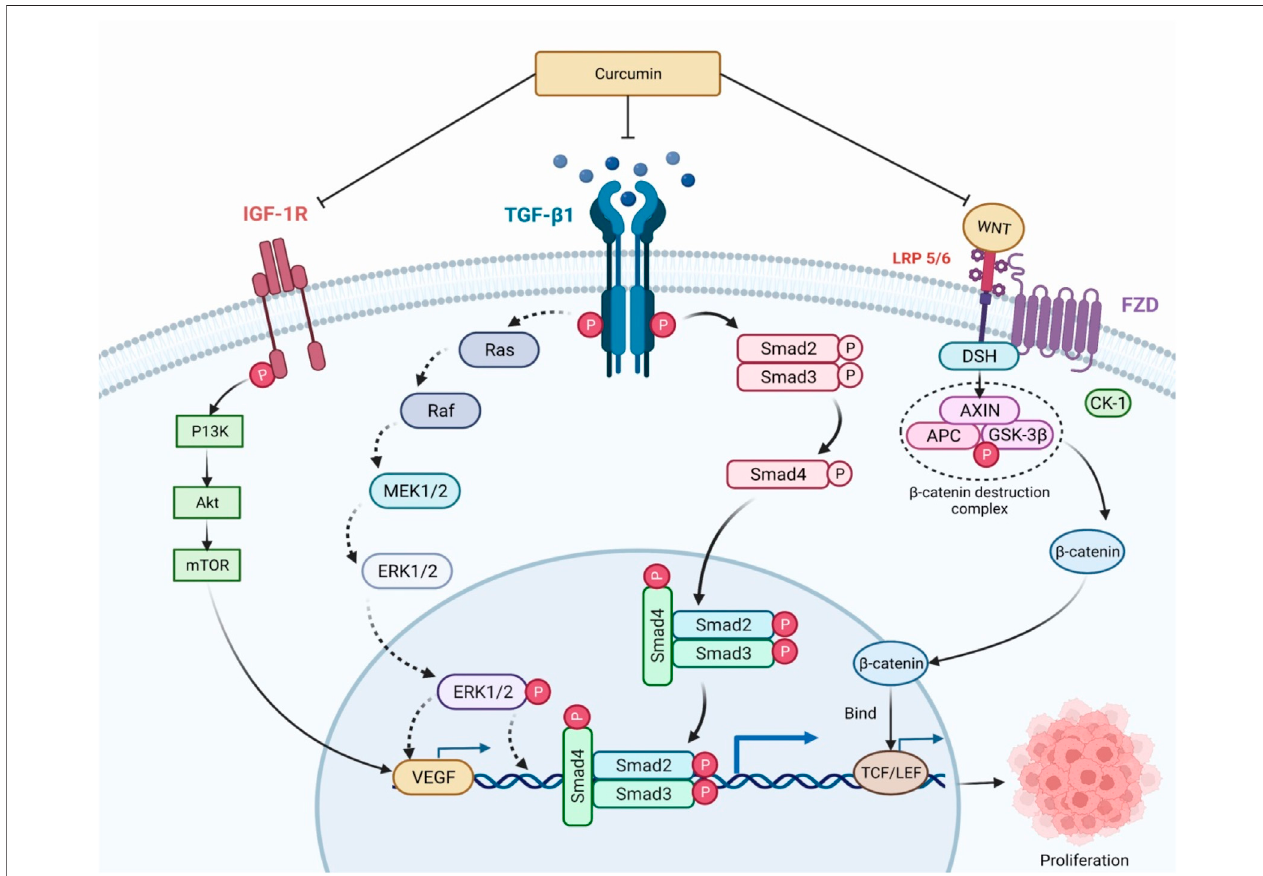
FIGURE 7 | Mechanism of curcumin in regulation of cancer proliferation. TGF- β 1/smad3, IGF, PI3K/Akt, Wnt/ β -catenin, and vascular endothelial growth factor (VEGF)aresomeofthesignalingpathwaysandmoleculartargetsthatcurcuminmodulatestoinhibitcancer.Blockingthesereceptorshasthepotentialtoreducechronic in fl ammation and oxidative damage. DSH and AXIN are recruited once the WNT binds to LRP 5/6, producing the β -catenin destruction complex. β -catenin that has escapedintothenucleuspromotesthetranscriptionofgenesincludingcyclinD1andP13k,whichpromotecellproliferationandgrowth.IGF-1R,Insulin-likegrowth factor 1 receptor; TGF- β 1, Transforming growth factor beta 1; WNT, Wingless/integrated; LRP 5/6, Low-density lipoprotein receptor-related protein 5/6; Smad, small mothers against decapentaplegic; Ras, Rat sarcoma virus; Raf, Rapidly Accelerated Fibrosarcoma; MEK 1/2, Mitogen-activated protein kinase 1/2; ERK ½, Extracellular-signal-regulated kinase ½; P13K, Phosphoinositide 3-kinases; Akt, Ak strain transforming; mTOR, mammalian target ofrapamycin; TCF/LEF, T-cellfactor/ lymphoid enhancer factor; FZD, Frizzled; DSH, Dishevelled; AXIN, Axis Inhibitor; APC, Adenomatous polyposis coli; GSK-3 β , Glycogen synthase kinase-3 beta; CK-1, casein kinase